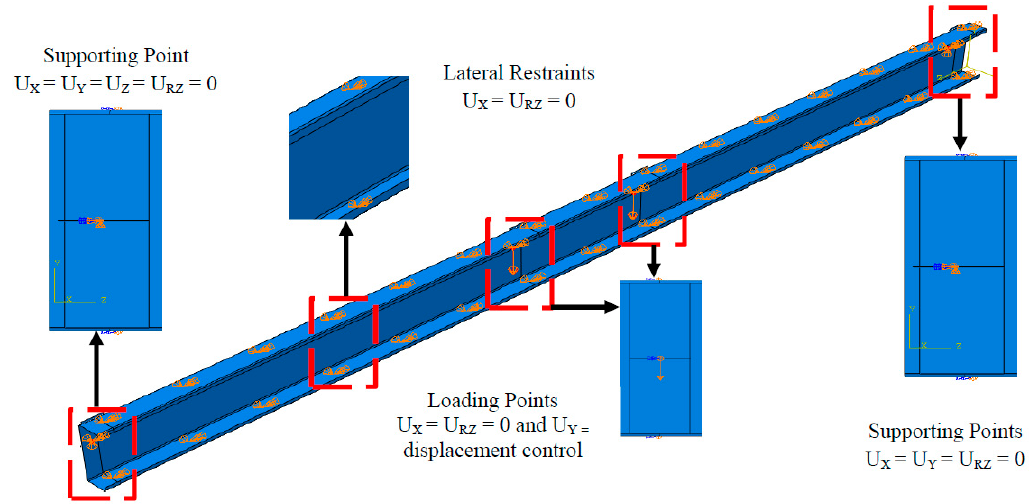
Figure 6. Boundary conditions of built-up sections.